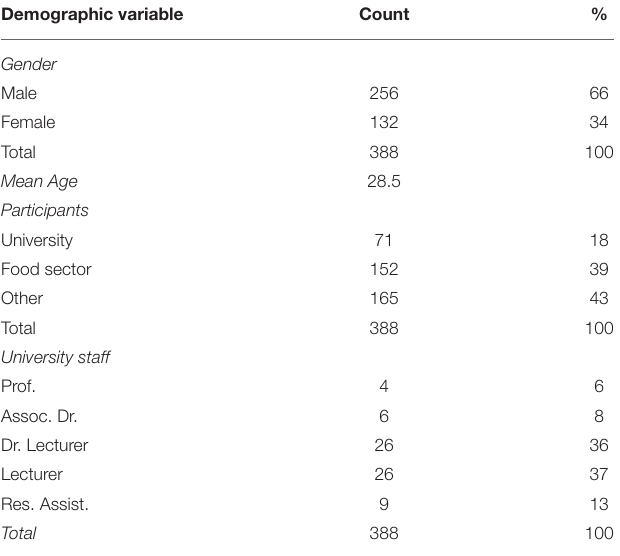
TABLE 2 | Demographic information of